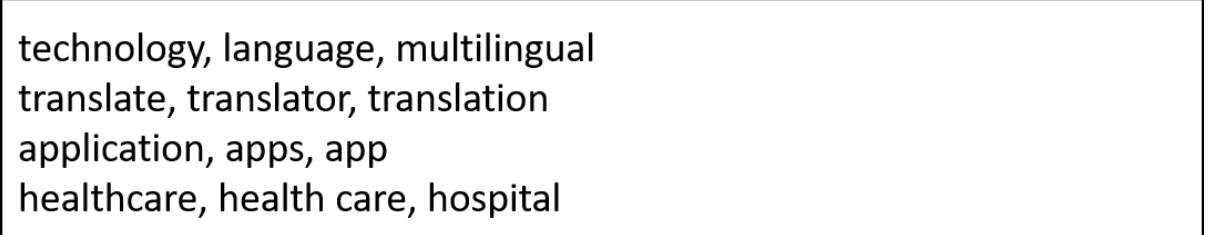
Figure 1. Search Terms for Apple